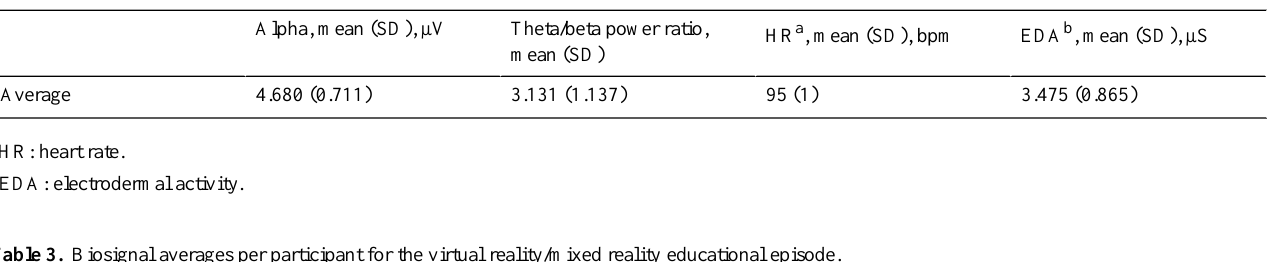
Table 2. Biosignal average of a representative participant (neurosurgeon) during the virtual reality/mixed reality educational episode.